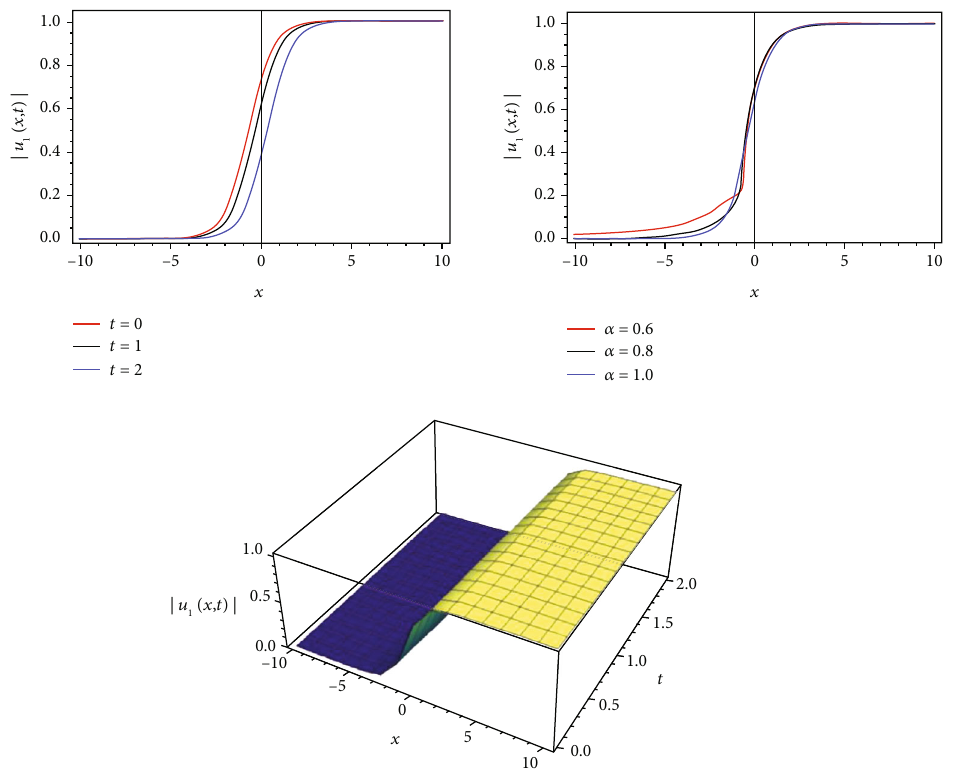
Figure 10: 2D and 3D graphics of Case 1 for hyperbolic traveling wave solution (62) at f α = 0 : 6, k = 0 : 7, a = 1, b = 1, c = 0 : 5, λ = 1 g